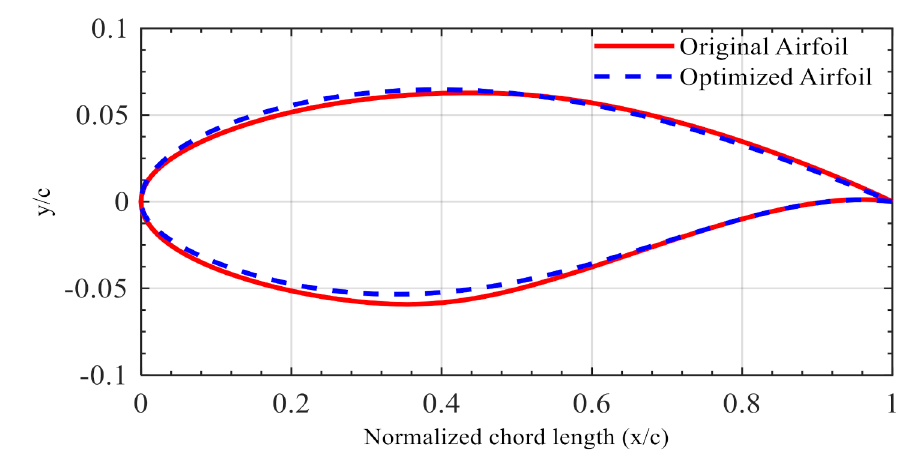
Figure 10. The shape comparison of an original and optimized airfoil